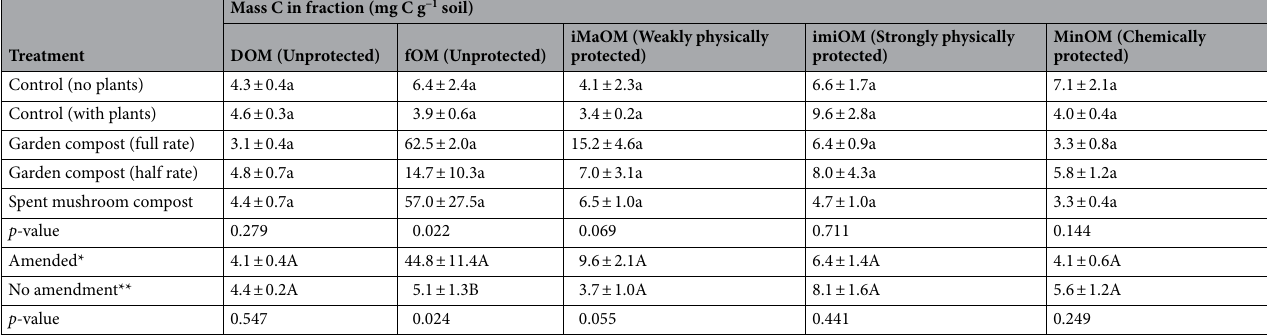
Table 3. C Content of physical fractions of 0–15 cm soil. Mean ± standard error (n = 3). Fractions: DOM dissolved organic matter, fOM free organic matter, iMaOM intra-macroaggregate OM, imiOM intra- microaggregate OM, MinOM mineral associated OM. Treatments that share suffix lowercase letters, in the same column, are not significantly different according to one-way ANOVA and Tukeys post hoc testing ( p < 0.05) for that particular fraction. Suffix upper case letters signify significant differences if all amended (garden compost or spent mushroom compost) or no amendment (controls) treatments are grouped together. *Mean of garden compost (full rate), garden compost (half rate) and spent mushroom compost (n = 9). **Mean of control (with plants) and control (no plants) (n = 6).